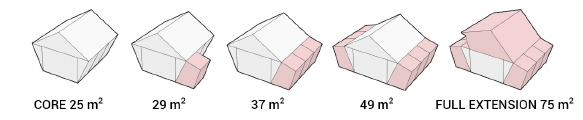
Fig. 9. Core House to Full Extension Massing.